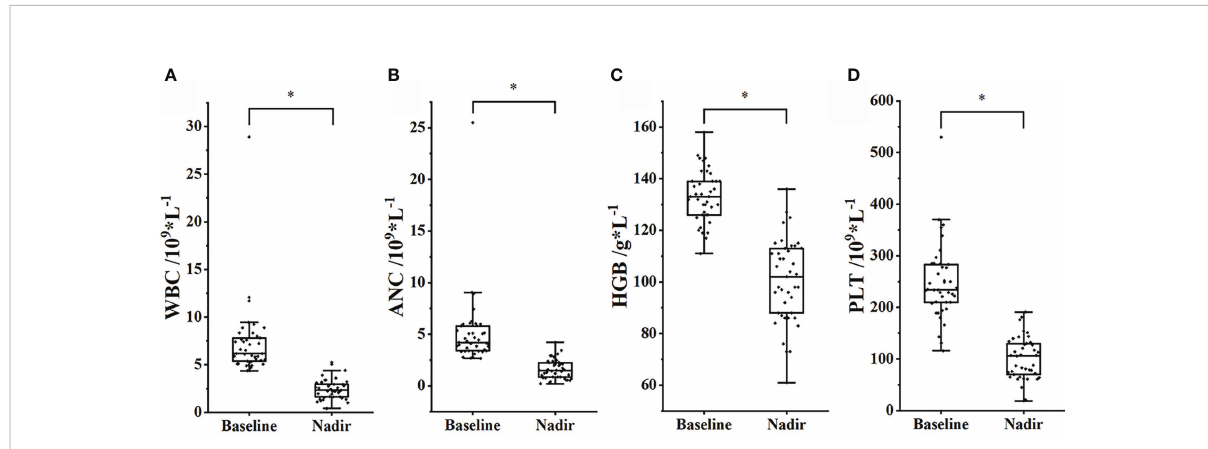
FIGURE 2 Changes in peripheral blood cell count between baseline and nadir. (A) WBC. (B) ANC. (C) HGB. (D) PLT. *, p<